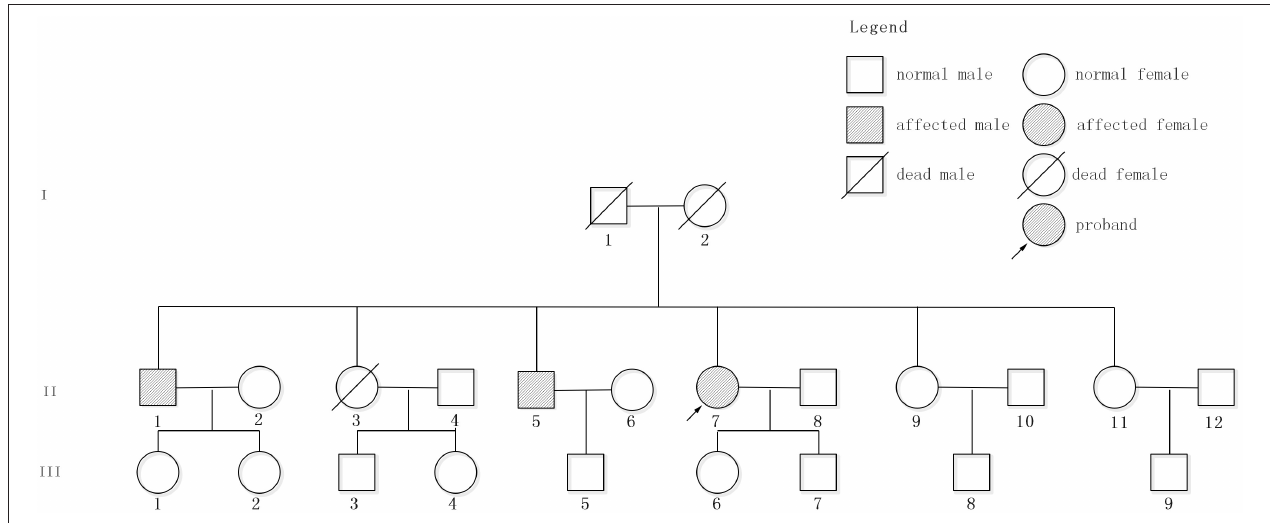
FIGURE 2 | Pedigree of the studied family. Patient II7, indicated by the arrow, is the proband. II1 and II5 had cerebral hemorrhage without hypertension.